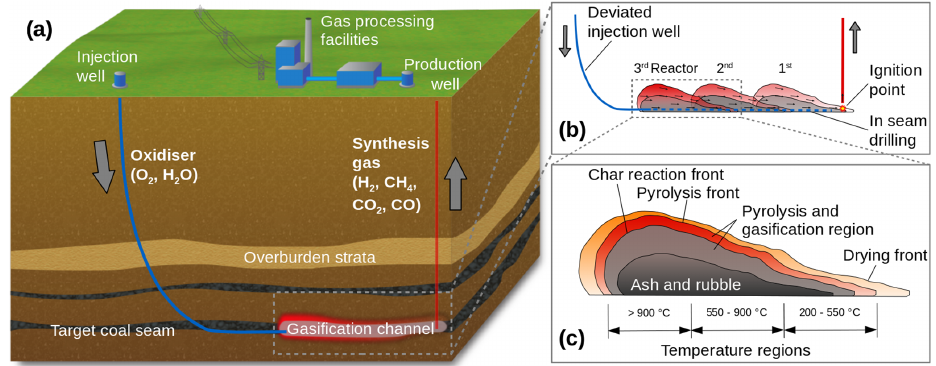
Figure 1. (a) Schematic view (not to scale) of the principle of in situ coal conversion based on the linear CRIP (Controlled Retracting Injection Point) method modified after Kempka et al. (2011). (b) Near-field view of the in situ coal conversion channel with directional drilling design and stepwise reactor excavation. (c) Regions of specific temperatures and chemical reactions in and around the in situ coal conversion